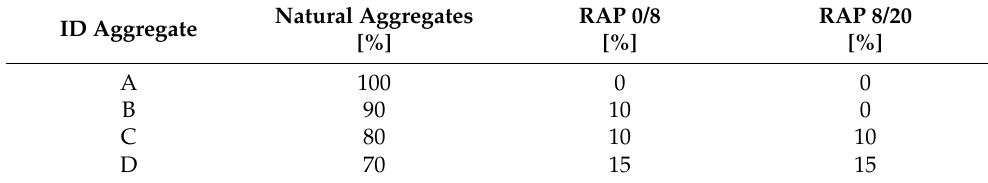
Table 1. Aggregates